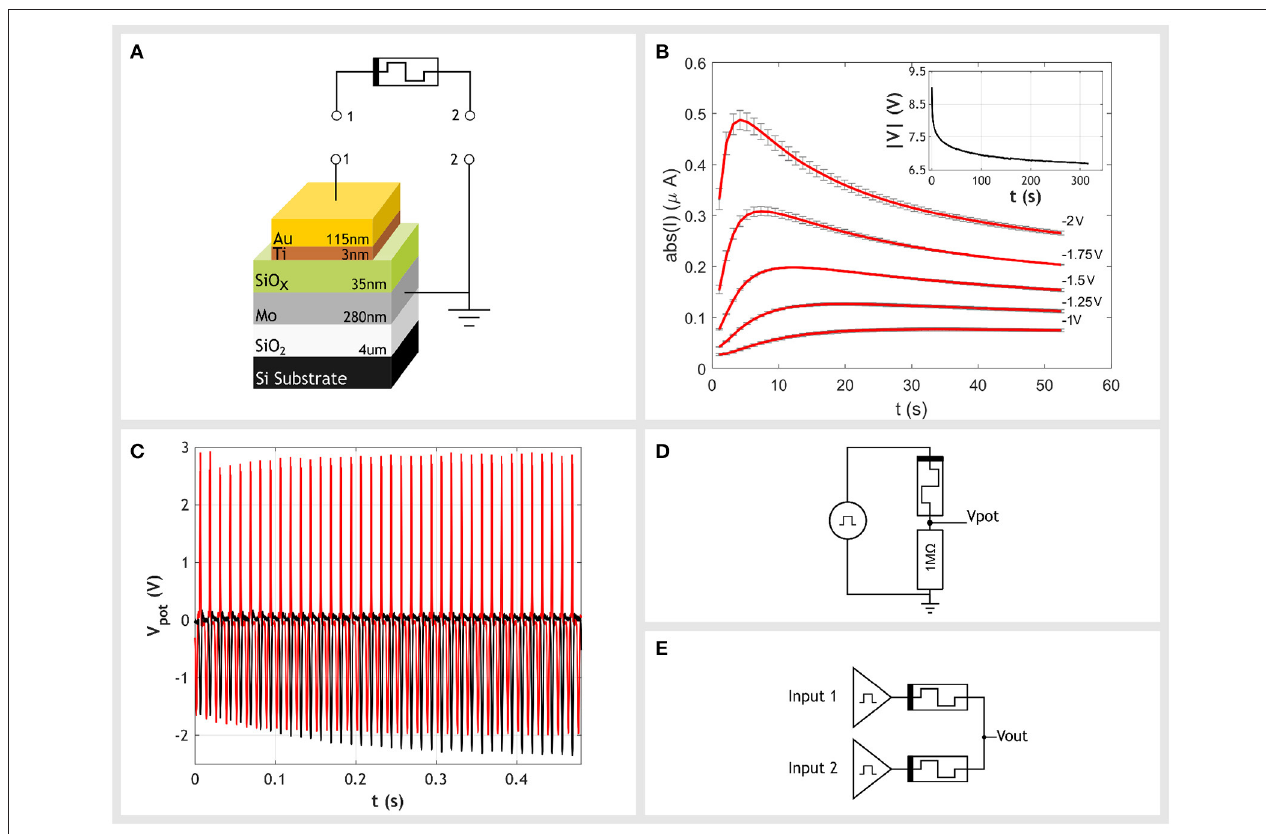
FIGURE 1 | (A) Our devices use an active layer of 35 nm sputtered amorphous silicon oxide. The bottom contact is a 280 nm layer of molybdenum and the top contact is a 115 nm layer of gold with a 3 nm wetting layer of titanium. (B) Examples of the current transients which occur when constant negative voltages